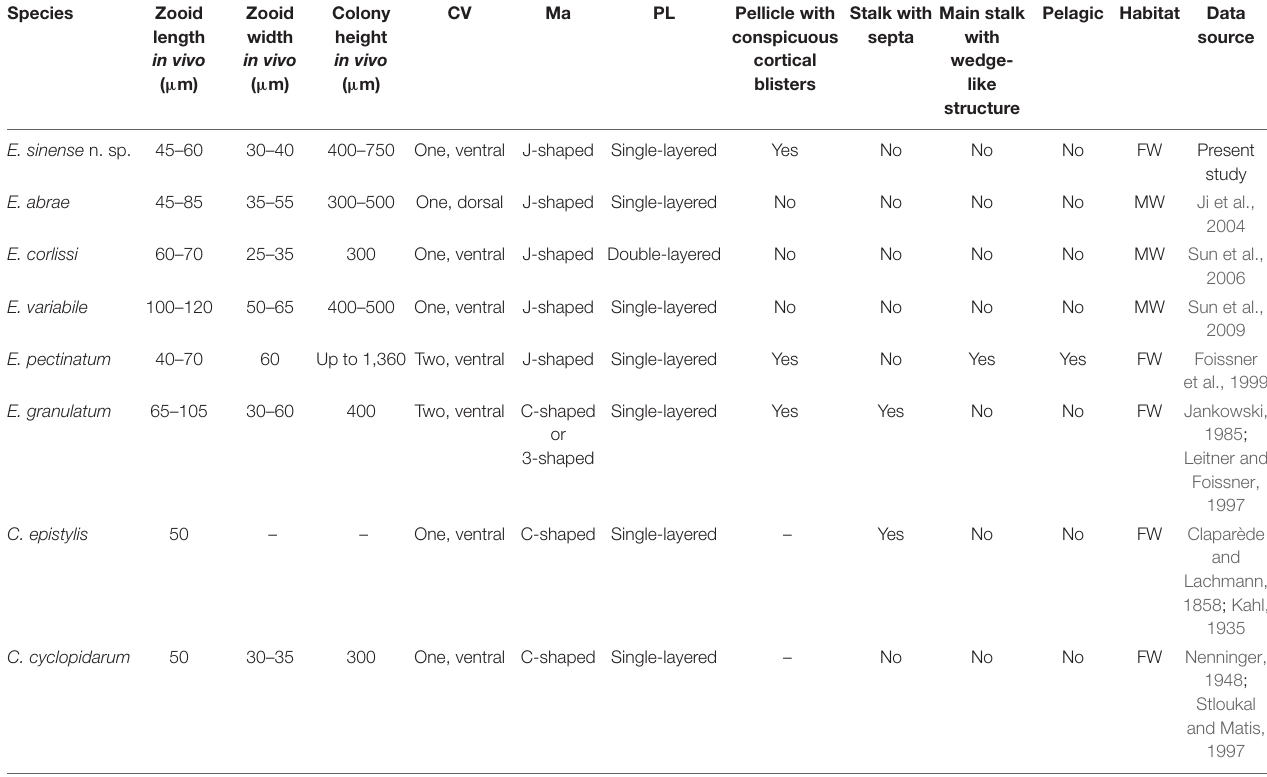
TABLE 5 | Comparison of Epicarchesium sinense n. sp. with congeners and morphologically similar species of Carchesium . Species Zooid length